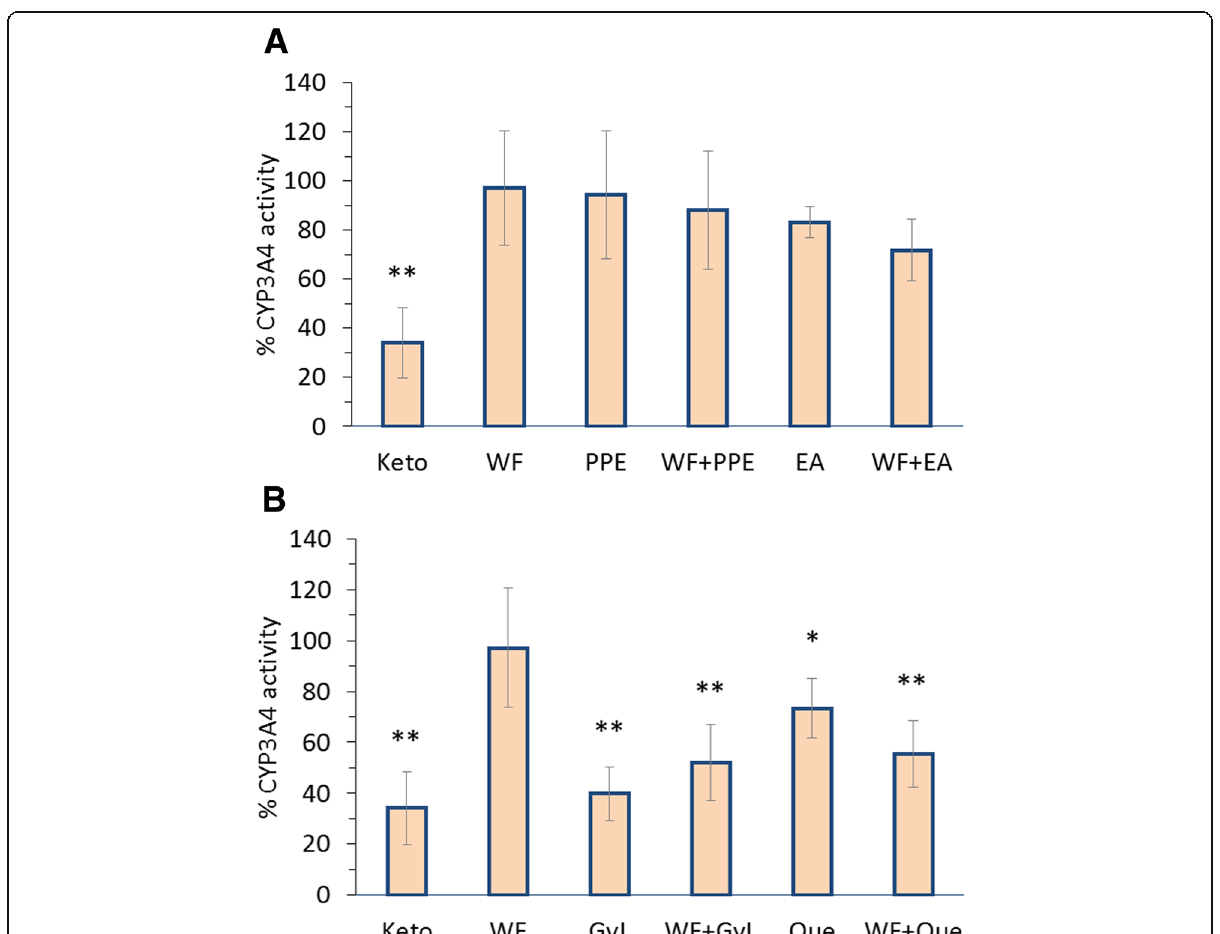
Fig. 5 Percentage of CYP3A4 activity relative to untreated isolated hepatocytes of different groups treated with ketoconazole (1 μ g/ml) and warfarin (3 μ g/ml) alone or in combination with: ( a ) pomegranate peel extract (120 μ g/ml), ellagic acid (48 μ g/ml) or, ( b ) guava leaves extract (294.1 μ g/ml) and quercetin (15 μ g/ml). Each data point represents the mean ± SD ( n = 6). Statistical evaluation was performed by comparing the percentage of activity of untreated cells with treated cells *p < 0.05, **p <